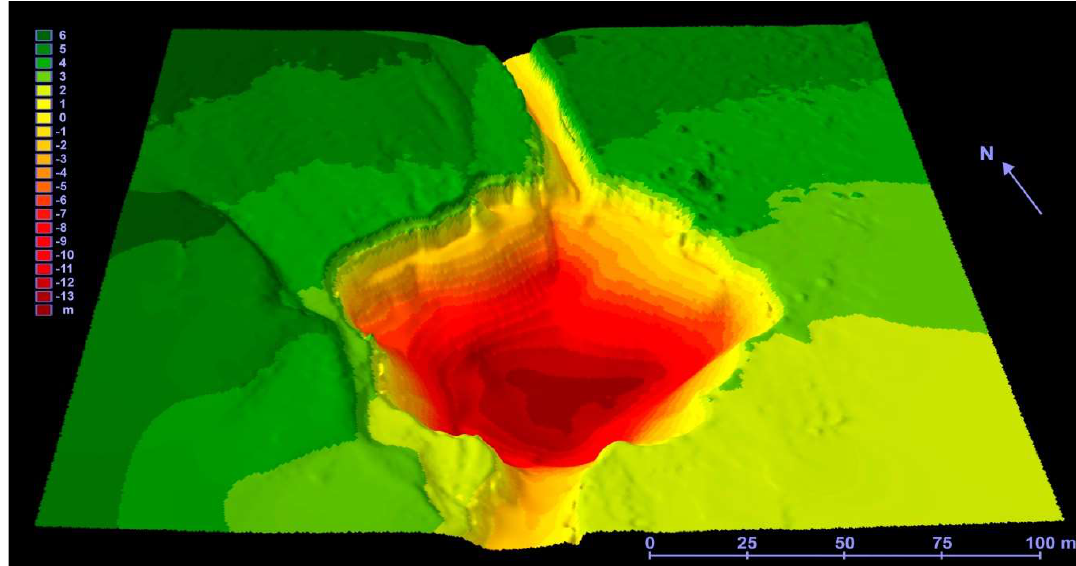
Figure 9. Complex 3D DEM of the Seyakha C11 gas blowout area surface.